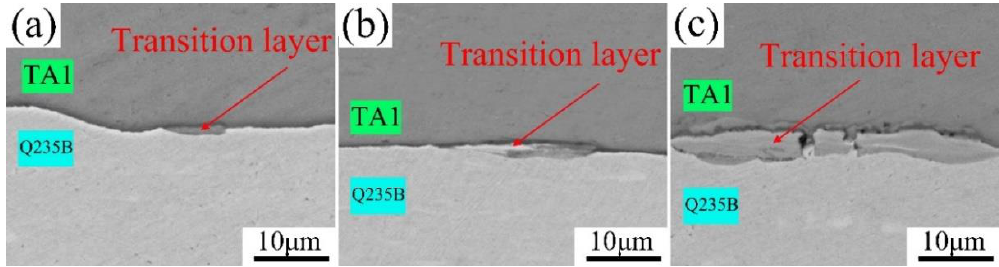
Figure 6. Interface SEM microstructure of TA1/Q235B sheets hot-rolled at ( a ) 1003 K, ( b ) 1053 K, ( c ) 1103 K.